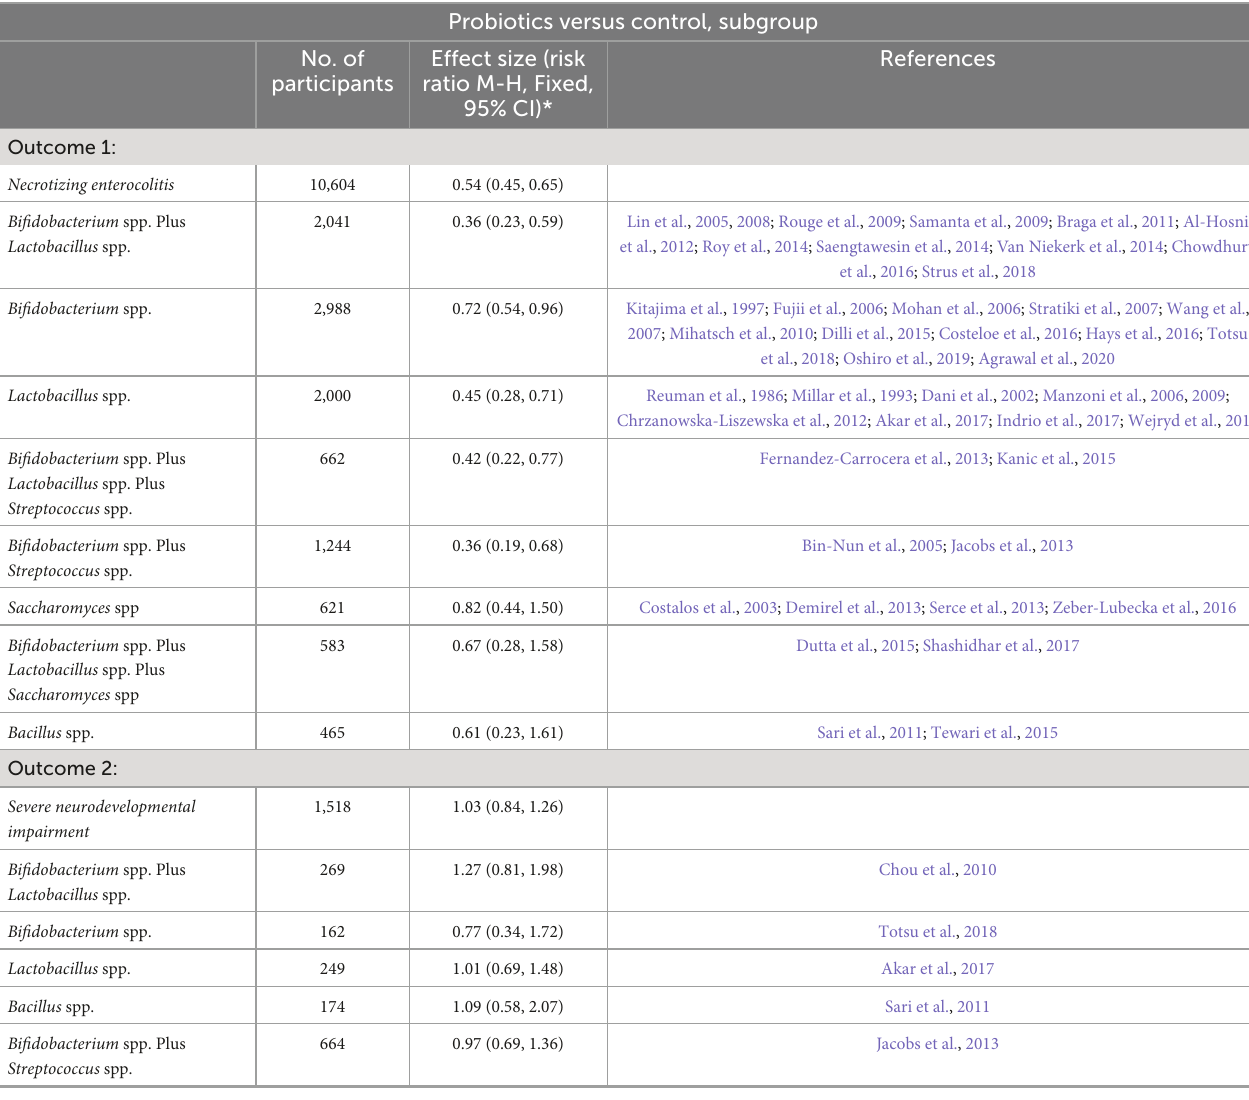
TABLE 1 Probiotics for very preterm or very low birth weight infants to prevent Necrotizing enterocolitis (NEC) based on Cochrane